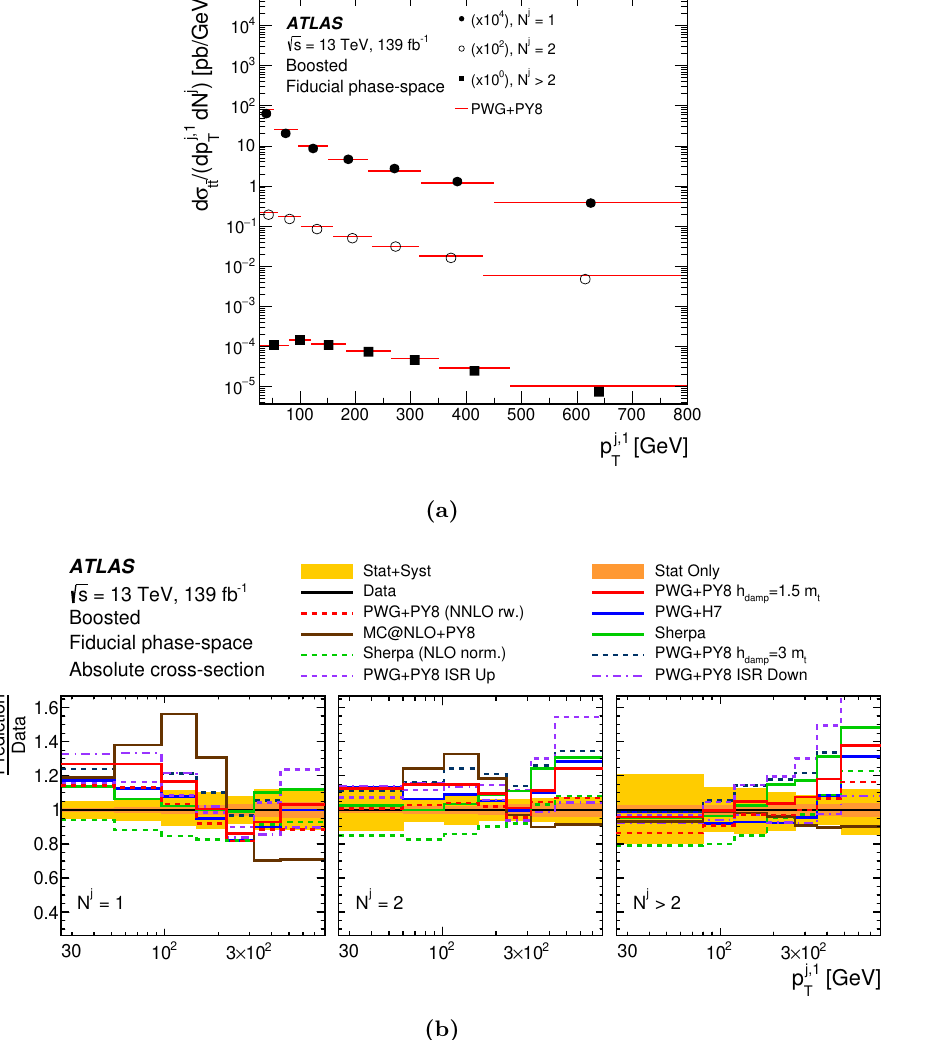
of the leading T